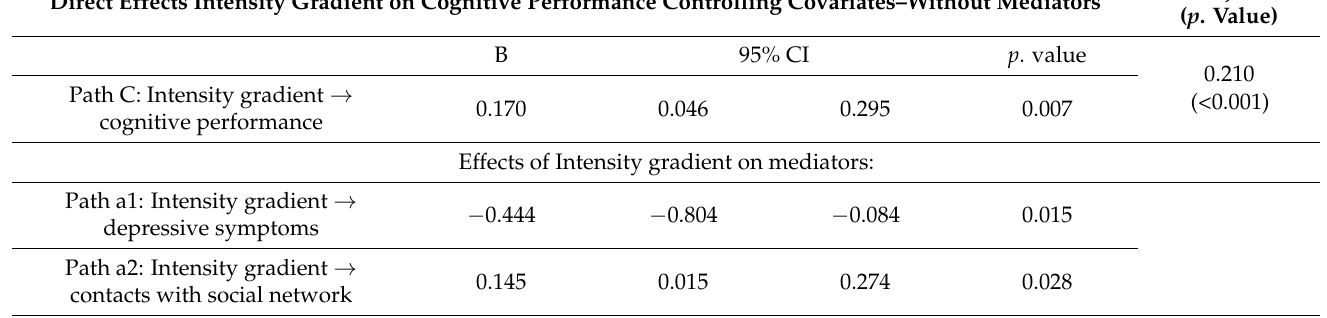
Table 3. Direct and indirect effect of intensity gradient on cognitive performance through depression and contacts with family (N =